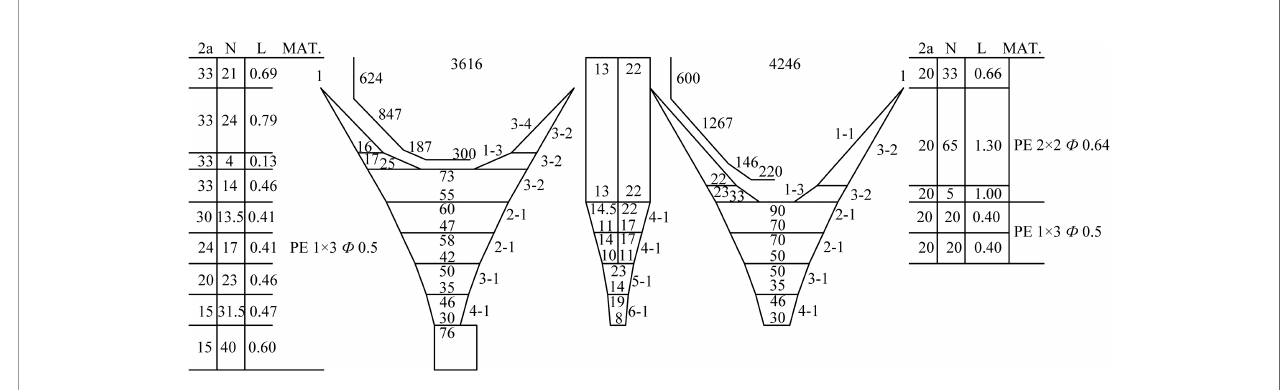
FIGURE 4 | Schematic net plan of the model trawl. Unit of net length (L), m; unit of mesh size (2a) and twine diameter ( F ), mm; unit of cable length, mm.